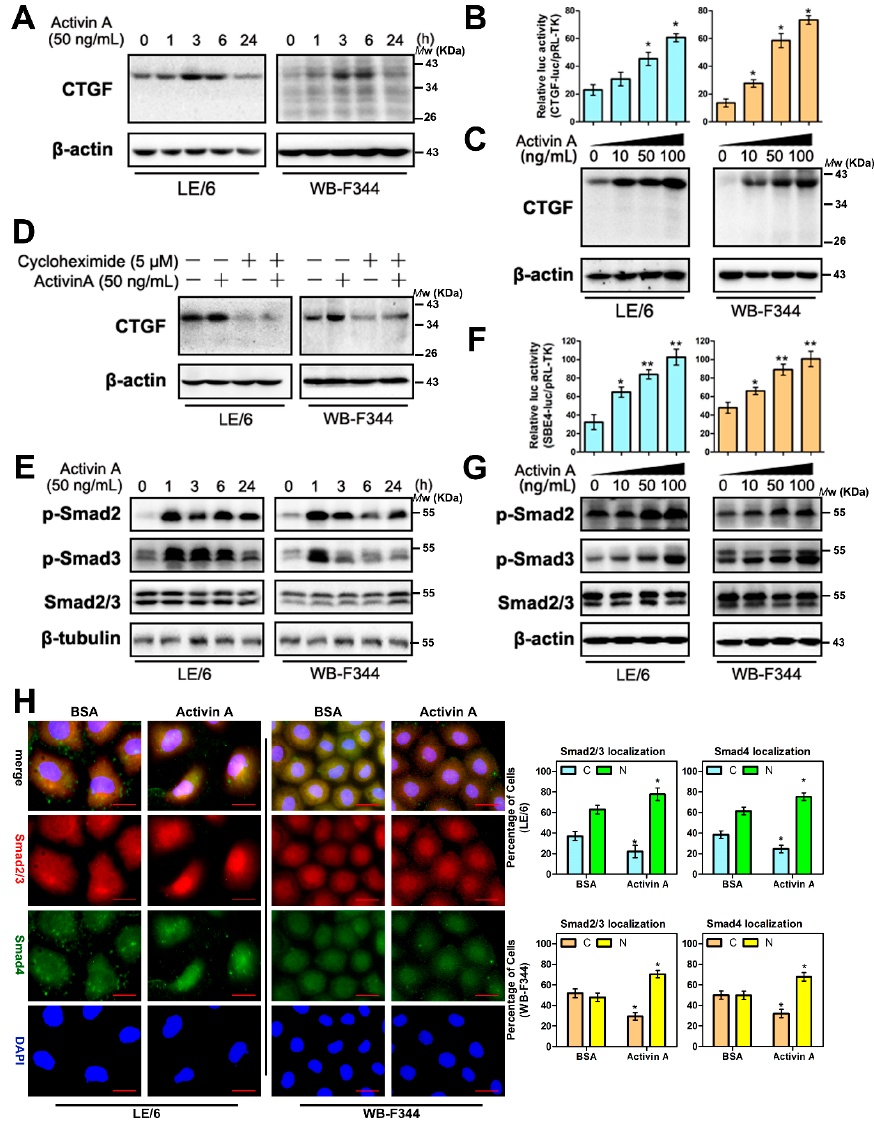
Figure 2. Activin A induces the production of CTGF/CCN2 in liver progenitor cells (LPCs). ( A , E ) LE/6 and WB-F344 cells were treated with Activin A (50 ng/mL) for the indicated times. Lysates were subjected to Western blot analyses with antibodies against indicated proteins. β -Actin ( A ) or β -tubulin ( E ) was used as a loading control; ( B , F ) LE/6 or WB-F344 cells was co-transfected with pRL-TK and CTGF-luc ( B ), or Smad binding elements (SBE4-luc) ( F ) plasmids as indicated, and then treated with Activin A at different concentrations as indicated for 16 h. Luciferase activity was normalized to renilla luciferase activity and expressed as the means ± S.E.M. of triplicate measurements. * p < 0.05 and ** p < 0.01 compared with the first bar; ( C , G ) LE/6 and WB-F344 cells were stimulated with Activin A at indicated concentrations. Lysates were subjected to Western blot analyses with antibodies against indicated proteins. β -Actin was used as loading control; ( D ) LE/6 and WB-F344 cells were treated with Activin A (50 ng/mL) and cycloheximide (5 µ M) as indicated for 6 h. Lysates were subjected to Western blot analyses with antibodies against CTGF/CCN2. β -actin was used as a loading control; ( H ) Upper panel : LE/6 and WB-F344 cells were treated with Activin A (50 ng/mL) for 1 h and then subjected to double immunofluorescent staining of Smad2/3 (red) and Smad4 (green); DAPI were used to show the location of the nucleus (blue); scale bar, 20 µ m; Lower panel : quantification of cells that showed Smad2/3 ( left ) and Smad4 ( right ) cytosolic (C) and/or nuclear (N) staining. The pink color of the merged image showed the merged staining of Smad2/3 (red), Smad4 (green), and DAPI (blue). * p < 0.05, compared with their control group (BSA),